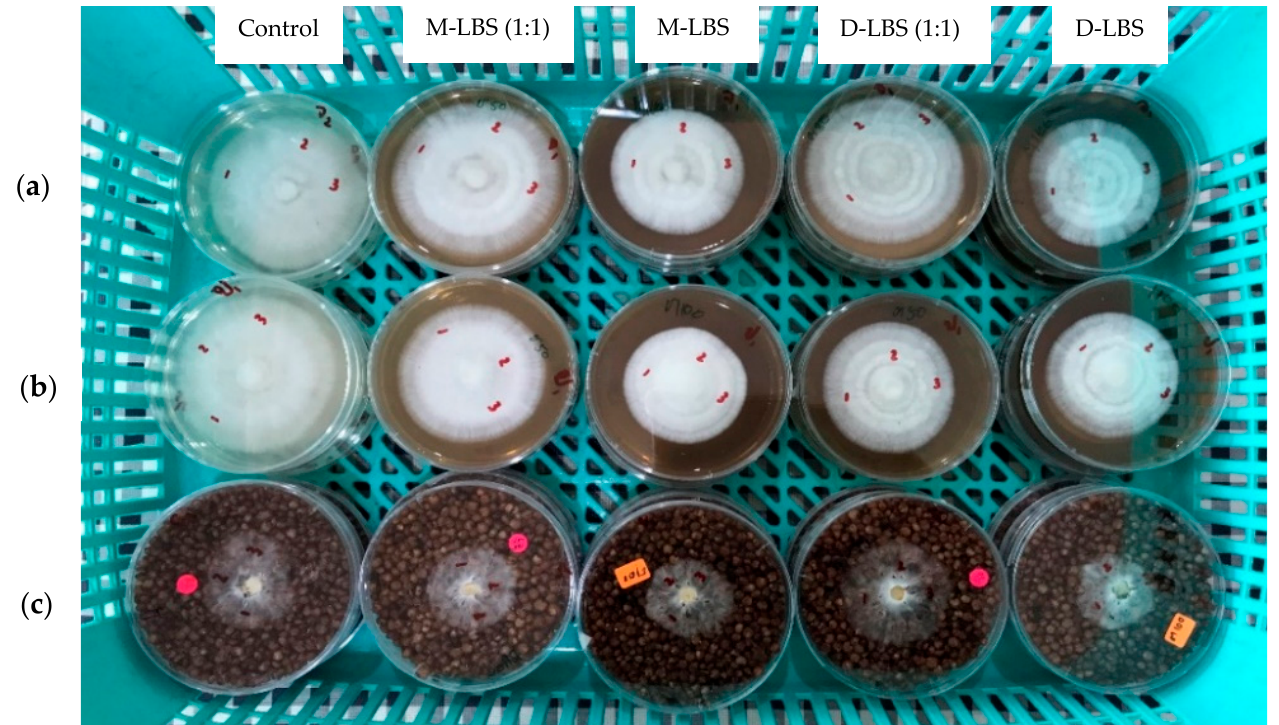
Figure 1 . P. sajor-caju mycelia growing on ( a ) Potato dextrose agar at 4 days, ( b ) Potato dextrose agar at 3 days, and ( c ) Sorghum grain at 2 days.